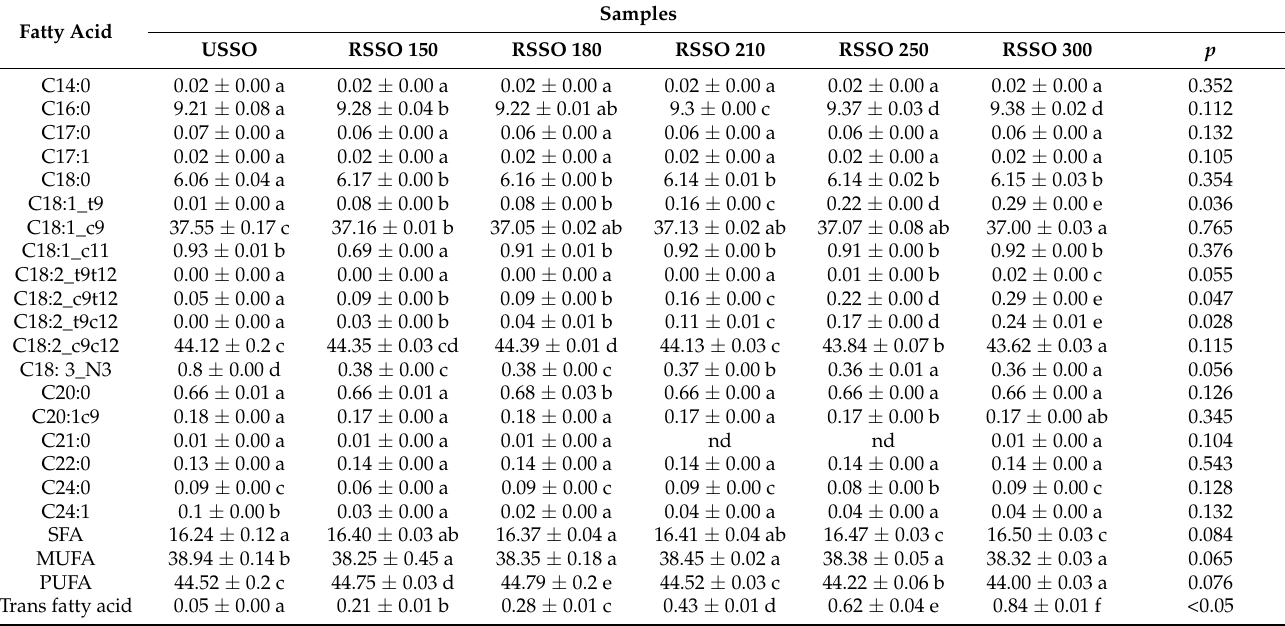
Table 2. Fatty acids composition expressed in % (g/100 g of oil) of unroasted and roasted sesame oils at different